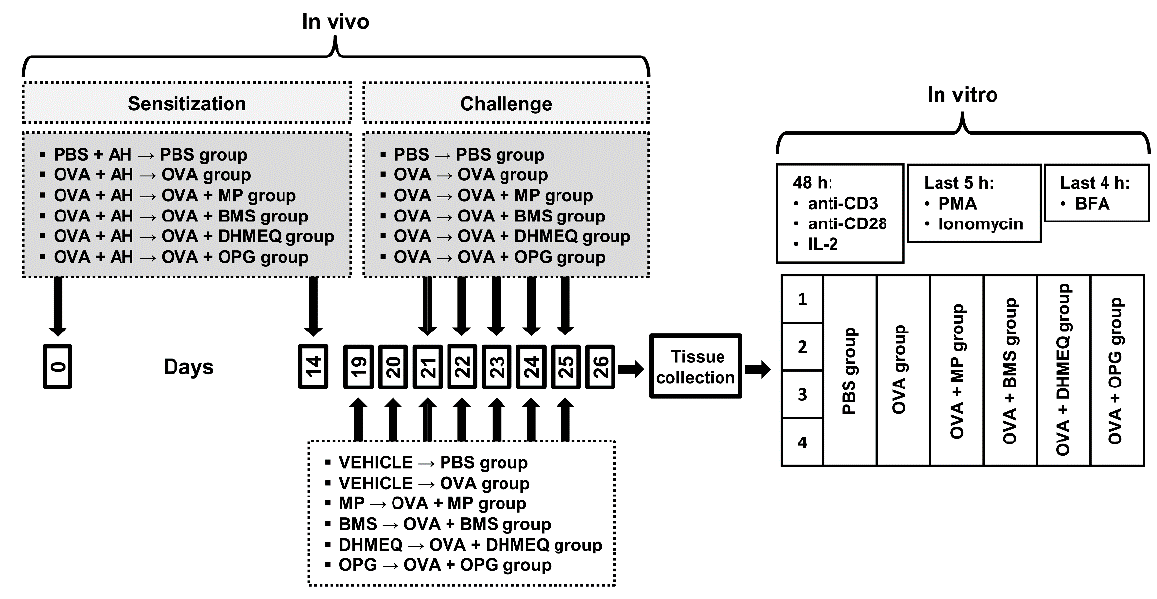
Figure 7. Experimental study design. Mice were divided into six groups, namely the PBS group (PBS-treated and -challenged mice, i.e., healthy mice/negative control), OVA group (ovalbumin (OVA)-sensitized and -challenged mice, i.e., mice with an OVA-induced model of allergic asthma/positive control), OVA + MP, OVA + BMS, OVA + DHMEQ and OVA + OPG groups (i.e., OVA-sensitized and -challenged mice treated with methylprednisolone (MP) or BMS-345541 (BMS) or dehydroxymethylepoxyquinomicin (DHMEQ) or osteoprotegerin (OPG)). Mice were sensitized to OVA by two intraperitoneal (i.p.) injections on days 0 and 14 with OVA absorbed on aluminum hydroxide (AH). Subsequently, mice were challenged intranasally with OVA (OVA, OVA + MP, OVA + BMS, OVA + DHMEQ and OVA + OPG groups) once daily on days 21–28. Mice in the negative control group (PBS group) received only AH in PBS (sensitization) or PBS alone (challenge). MP, BMS, DHMEQ, OPG and vehicles administration was started 48 h prior to the first challenge (i.e., on day 19 after the initial sensitization) and continued daily for 6 consecutive days; all studied agents and/or vehicles were given 3 h before OVA challenge. Mice were euthanized 24 h after the last administration of MP, BMS, DHMEQ, OPG or vehicles, and the mediastinal lymph nodes (MLNs) and lungs were harvested. Lymphocytes isolated from the MLNs and lungs were in vitro activated with plate-coated anti-CD3 and soluble anti-CD28 monoclonal antibodies in the presence of IL-2 for 48 h and re-stimulated with phorbol-12-myristate-13-acetate (PMA) and ionomycin for the last 5 h. Brefeldin A (BFA) was added for final 4 h of culture to inhibit cytokine release by cells. Subsequently, cells were harvested, stained extracellular, fixed, permeabilized, and then stained for intracellular production of IL-4, IL-10, IL-17 and TGF- β